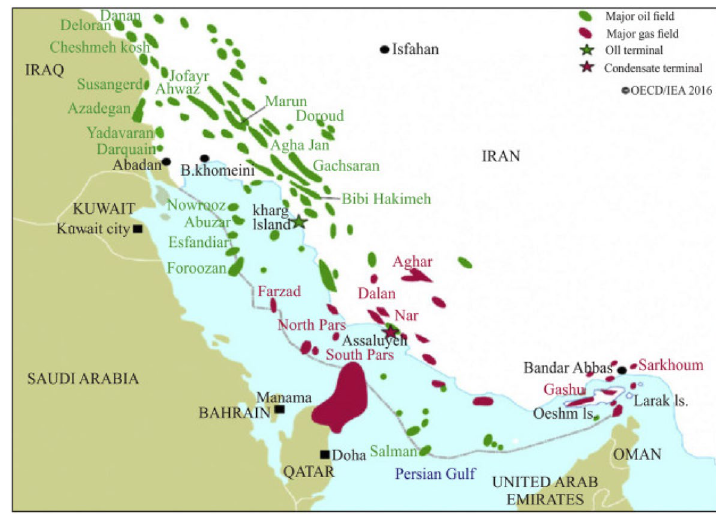
Fig. 1 Location of the